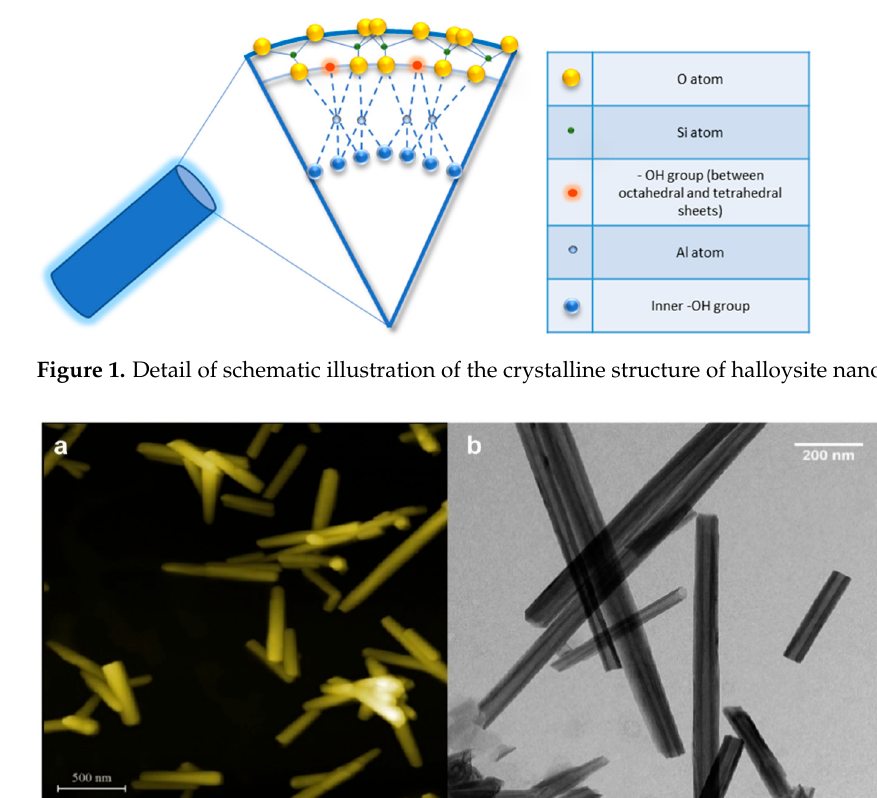
Figure 2. ( a ) Atomic force microscopy; ( b ) TEM images of halloysite nanotubes precipitated from aqueous dispersion. Adapted from [43]. aqueous dispersion. Adapted from